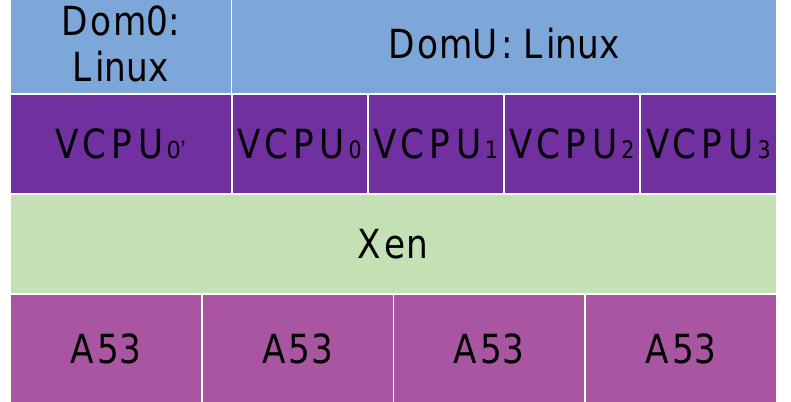
Figure 2. Scenario 2: Xen Linux Dom0 + Linux